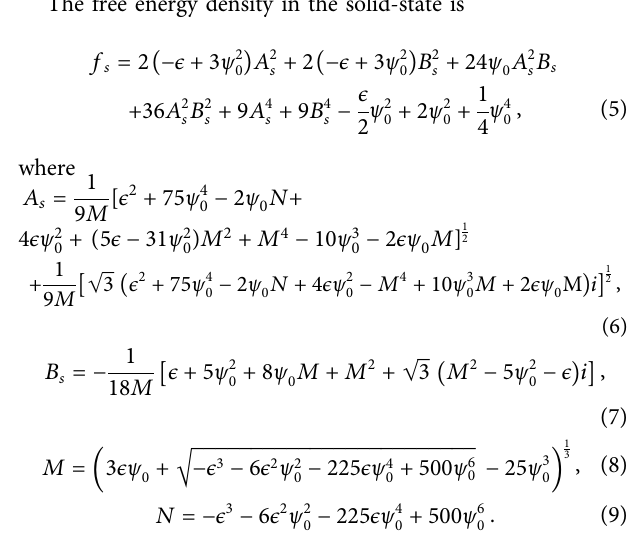
The phase diagram is derived by taking the derivative of free energy for the density fi eld of the square phase and liquid phase respectively and using the common tangent rule, as shown in Figure 1 .